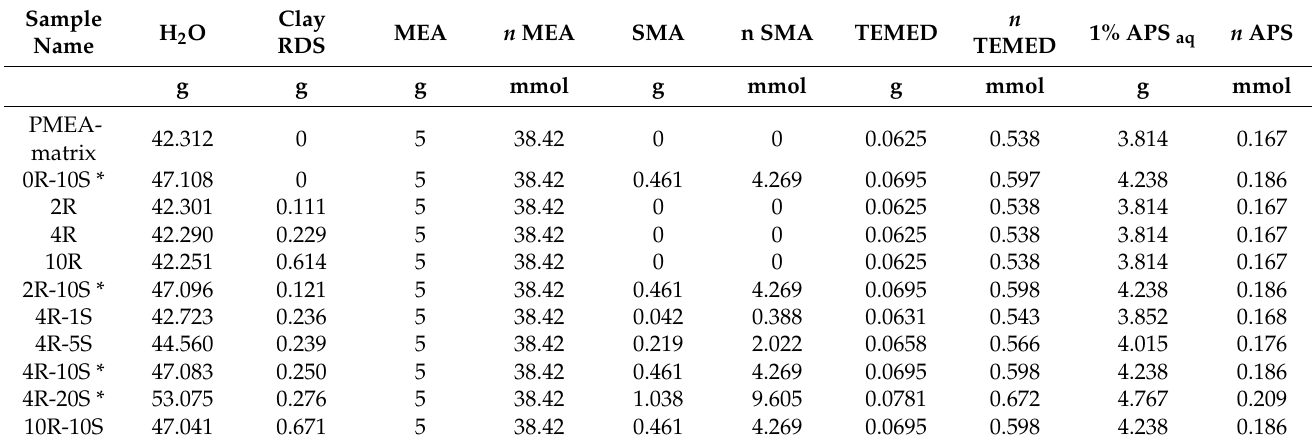
Table 1. Amounts of components for the syntheses of the studied nanocomposite elastomers. Abbre- viations: (‘RDS’ = product name of the clay, used by the supplier), MEA = 2-Methoxyethyl acrylate (main monomer), SMA = sodium methacrylate, TEMED = N,N,N (cid:48) ,N (cid:48) -tetramethylethylenediamine, APS = ammonium